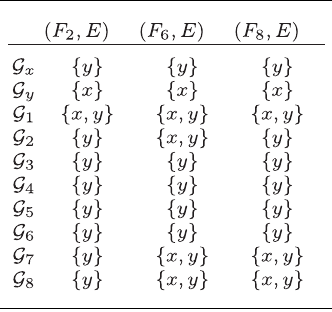
The extreme elements for three soft sets on X ¼ f x ; y g , in the convex soft geometries defined in Example 3. See Tables 1 and 2 for notation, and Table 4 for intermediate calculations